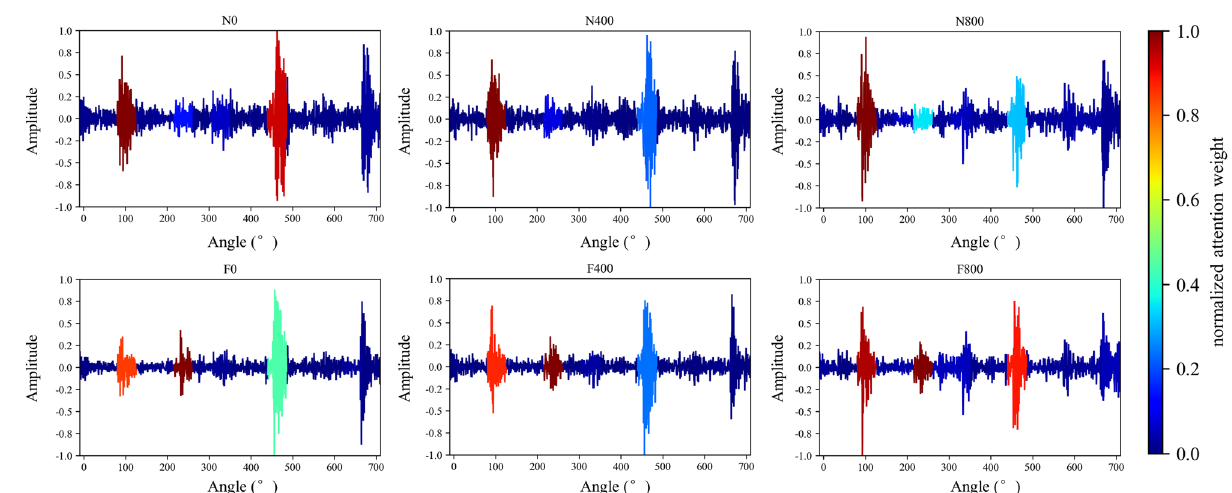
Figure 7. Visualization of attention weight on angular domain signal of various working